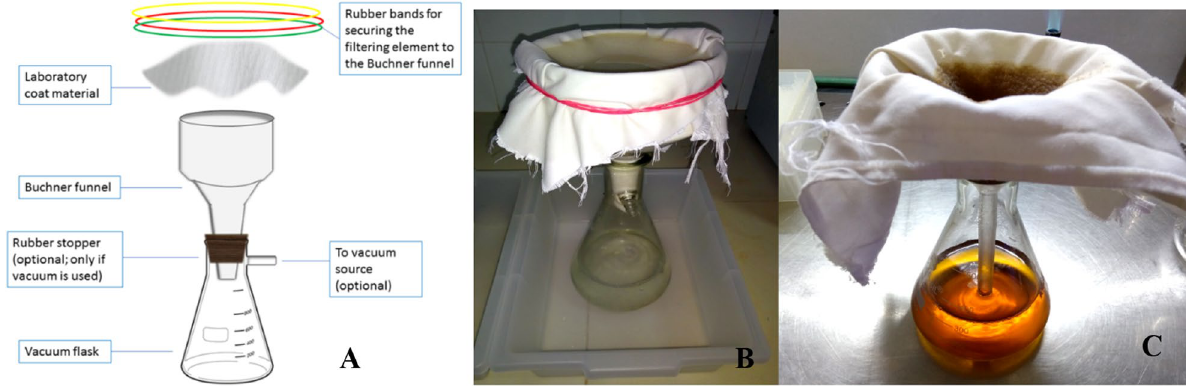
Figure 1. Apparatus used for the preparation of colloidal chitin (CC) and cell free supernatant (CFS). ( A ) The components of the lab coat clothing material (LCCM) based filtration apparatus. ( B ) Filtration setup used